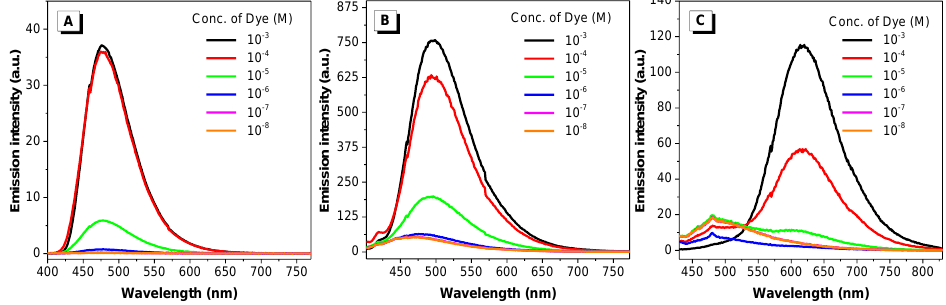
Figure 7. Emission spectra of dyes 1 ( A ), 2 ( B ) and 3 ( C ) at various concentrations in DMSO. Excitation wavelength: 390, 392 and 420 nm, respectively.